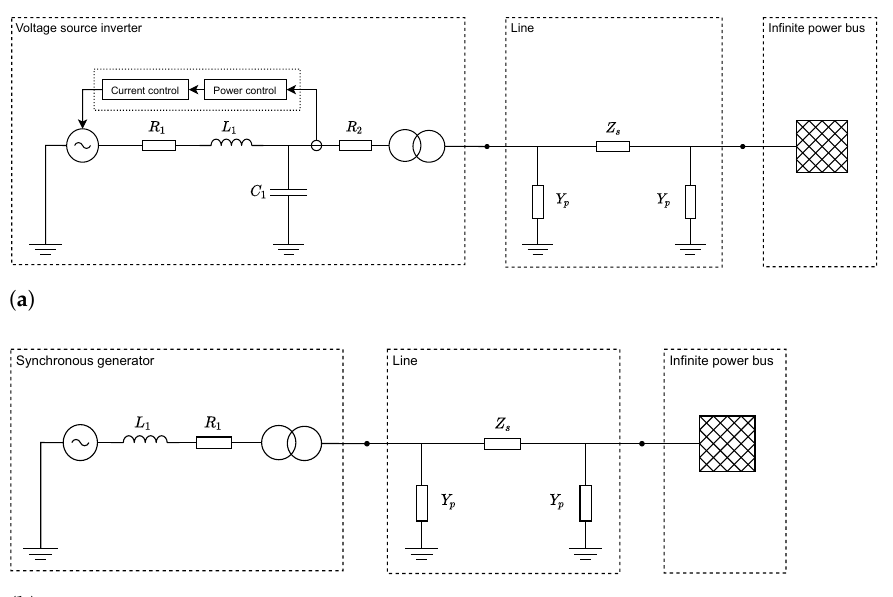
Figure 1. Test systems including ( a ) voltage source inverter interfaced generation or ( b ) synchronous